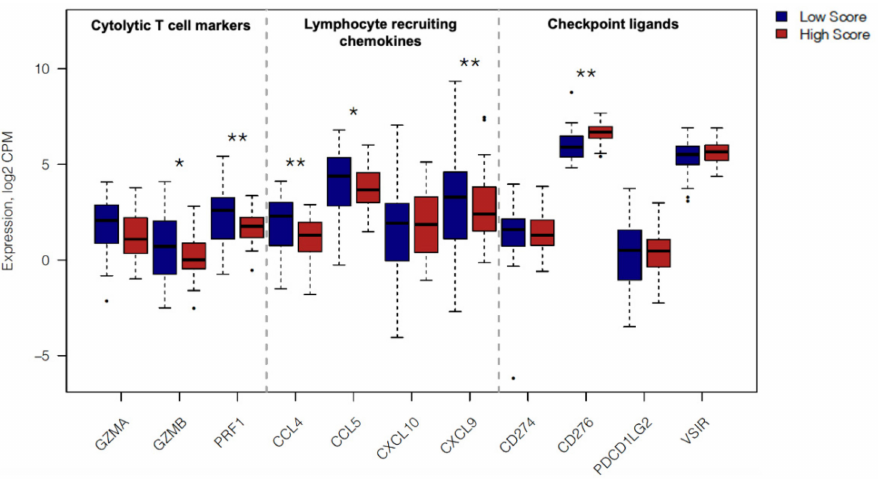
Figure 6. Immune related gene expression in TCGA PDAC cases with High and Low Budding gene signature scores. Boxplots comparing gene expression of immunological genes in High and Low Budding Score patients from TCGA ( n = 45 patients each). Gene expression is shown as log2-transformed, normalized CPM (counts per million) values. Transcriptome-wide differential expression statistics were computed using EdgeR under quasi-likelihood framework. P values were corrected for multiple testing using the Benjamini-Hochberg method limiting the correction to the 11 genes of interest displayed above. Only significant p values (<0.05) are shown on the graph. ** p < 0.01, * p <